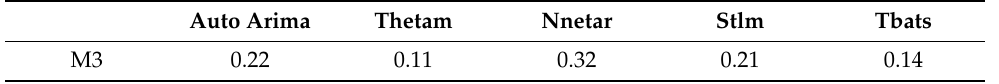
Table 8. Model’s M3 component weights for “psychologist” score forecasting. Auto Arima Thetam Nnetar Stlm Tbats